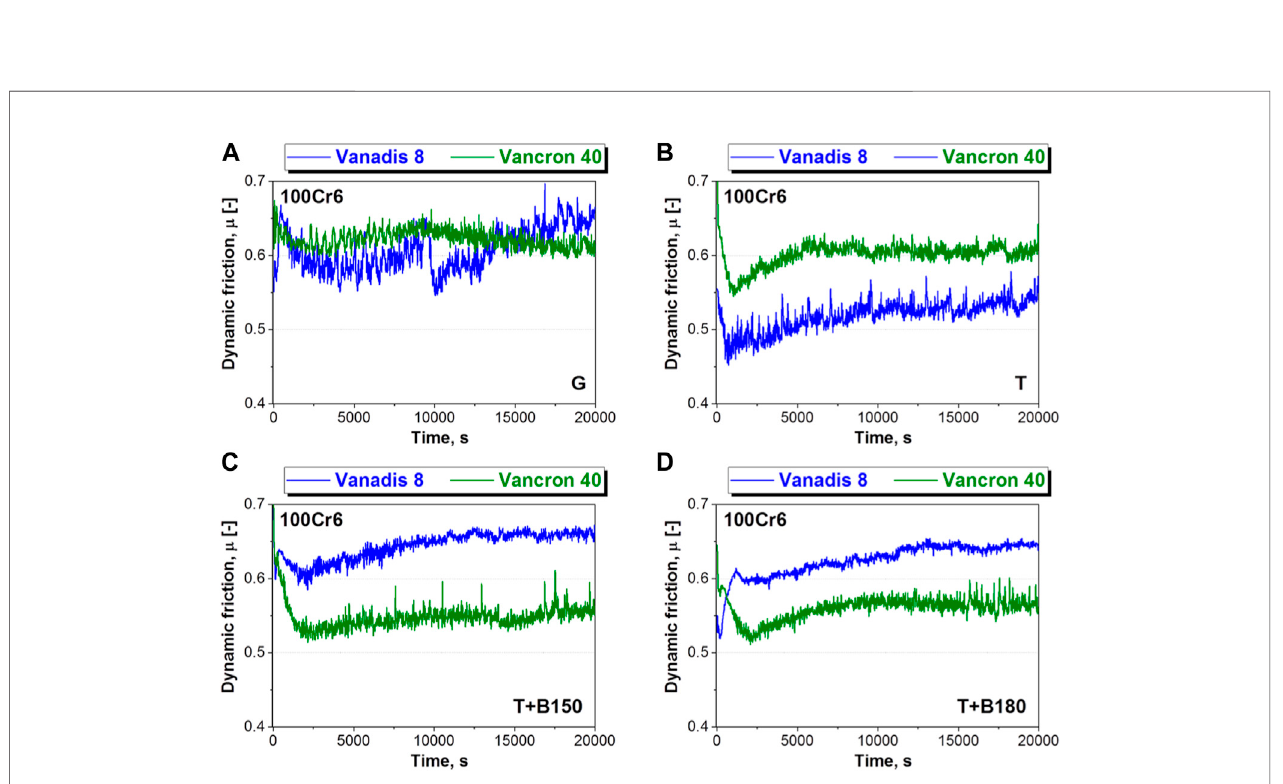
FIGURE 10 | Dynamic friction coef fi cients for Vanadis 8 and Vancron 40 samples, following the mechanical processes of SL modi fi cations: (A) G, (B) T, (C) T + B150, (D) T + B180. Ball-on-disc tests carried out against 100Cr6 pins.